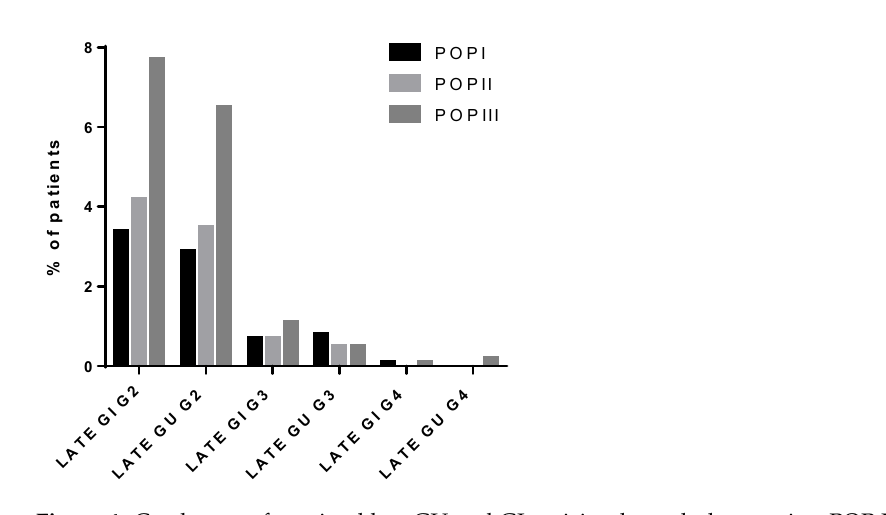
Figure 4. Crude rate of maximal late GU and GI toxicity through three series: POP I (1994–1998), POP II (1999–2003), POP III (2004–2011).